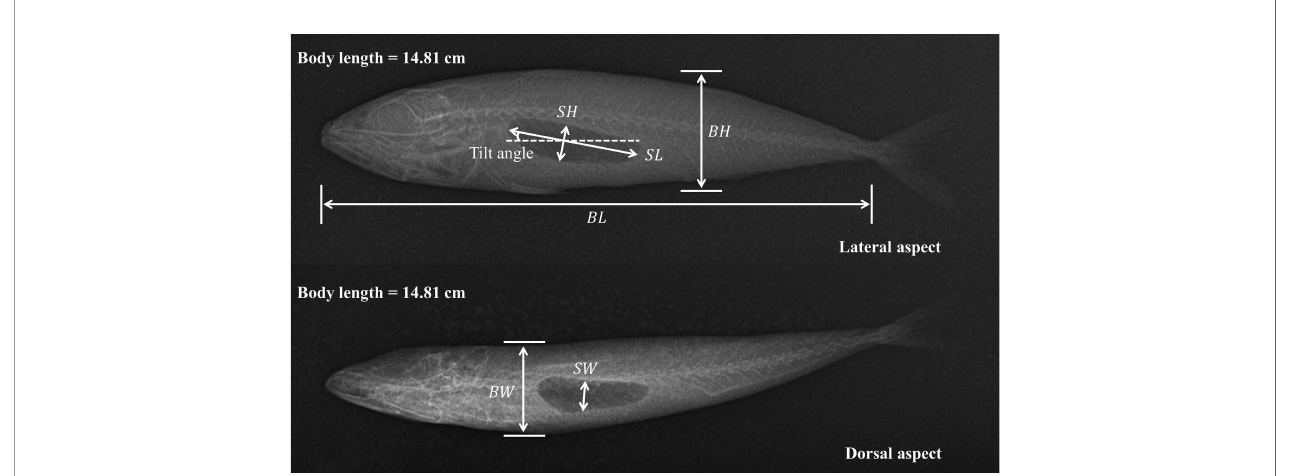
FIGURE 1 | Morphological measurements on lateral and dorsal X-ray images. The air- fi lled swim bladder can be seen as a dark shape within the fi sh body. The symbols BL, BH and BW represent body length, body height, and body width, respectively. While the symbols SL, SH and SW represent swim bladder length, swim bladder height, and swim bladder width,